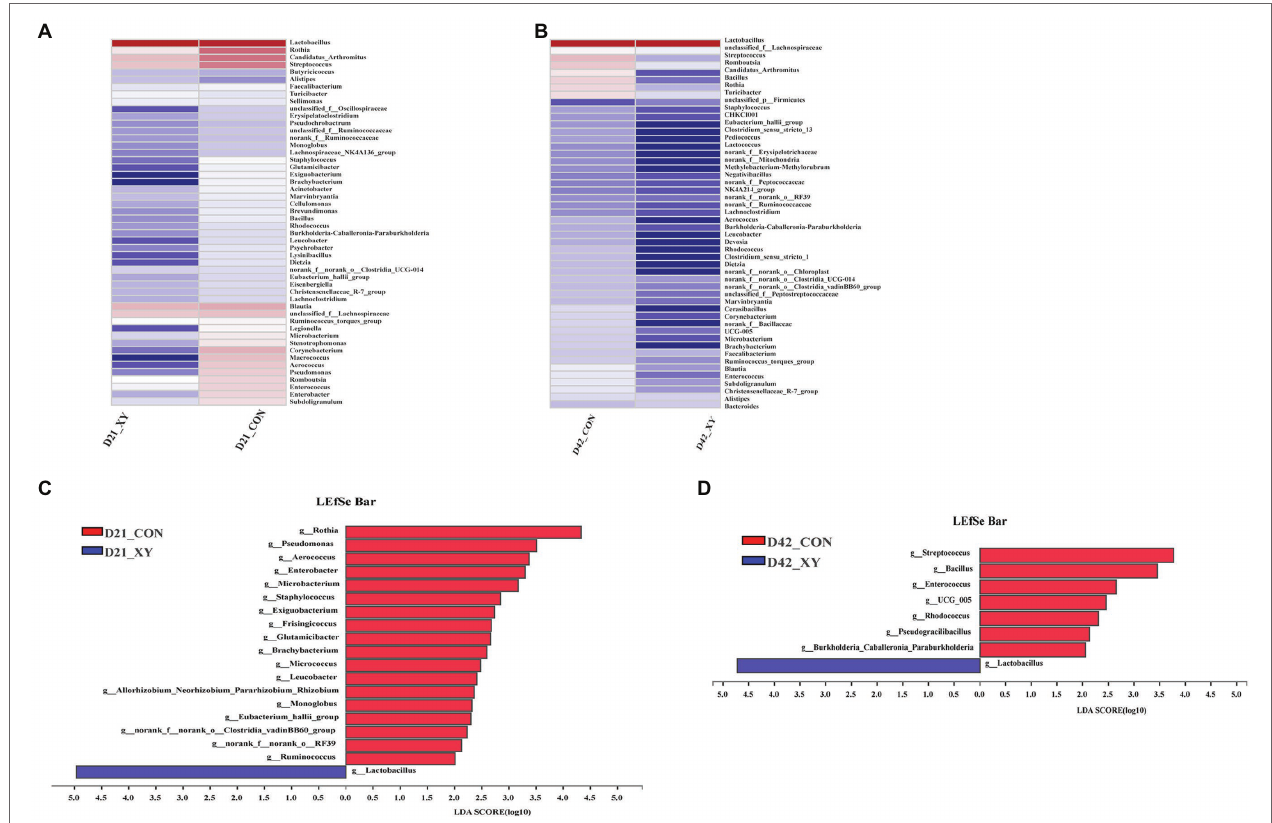
FIGURE 5 | Effects of AT-xynA on ileal microbiota composition at the genus level. (A,B) Ileal bacterial community heatmap at the genus level; (C,D) the analysis of different bacteria communities at the genus level in the cladogram of Linear discriminant analysis effect size between two groups. CON is AT-xynA un-supplemented group; XY is 4,000 U/kg AT-xynA supplemented